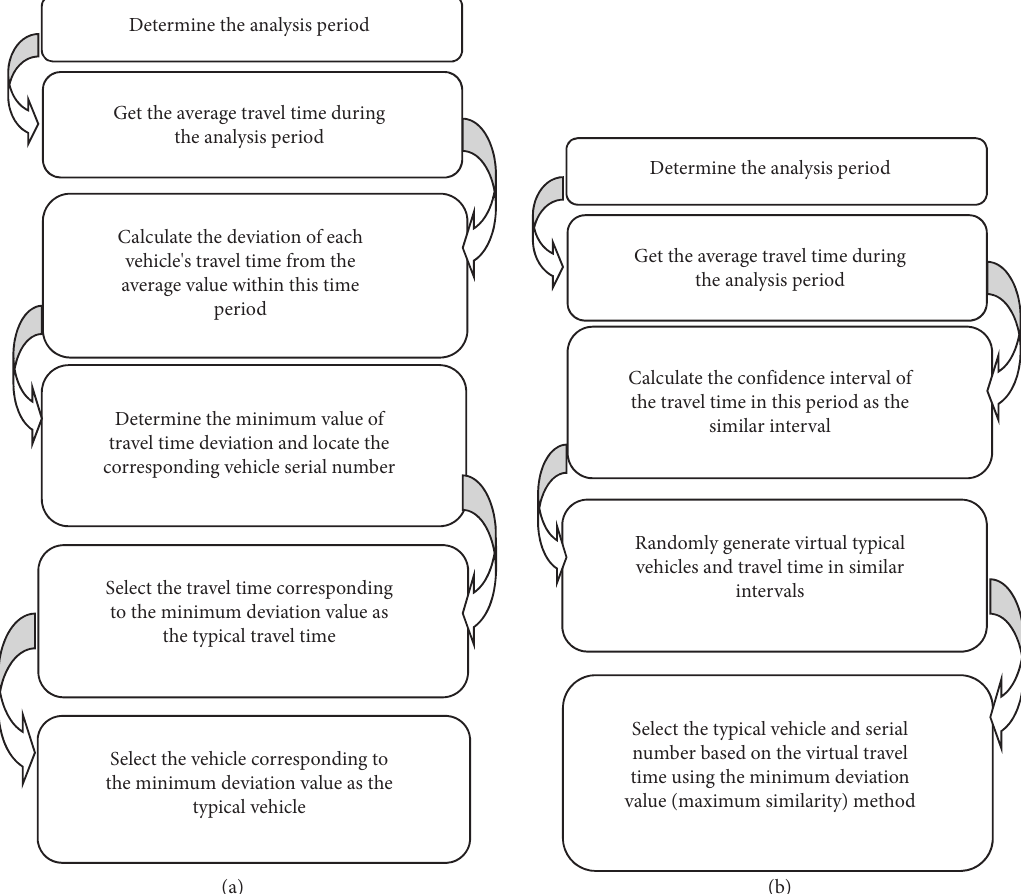
Figure 2: Two methods of link travel time data extraction: (a) method based on average travel time of typical vehicle; (b) method based on confidence interval of virtual typical vehicle travel